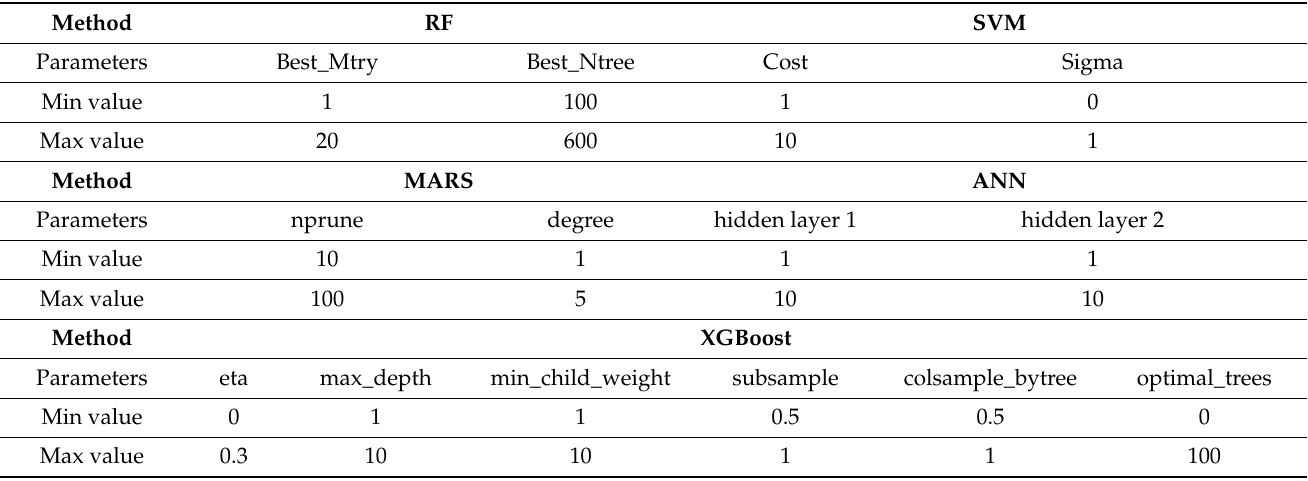
Table 3. Maximum, minimum values of six model